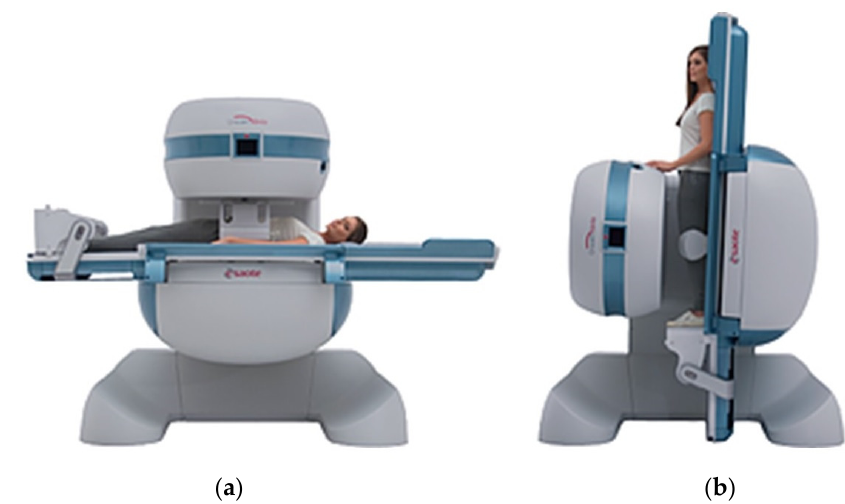
Figure 1. The employed MR scanner in traditional ( a ) and weight-bearing ( b ) configuration.